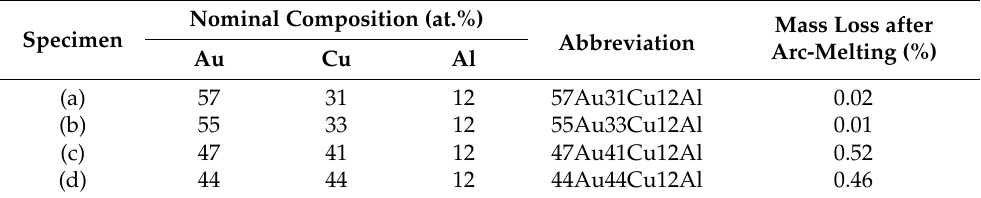
Table 1. Nominal compositions of the fabricated Au-Cu-Al alloys. Nominal Composition Specimen